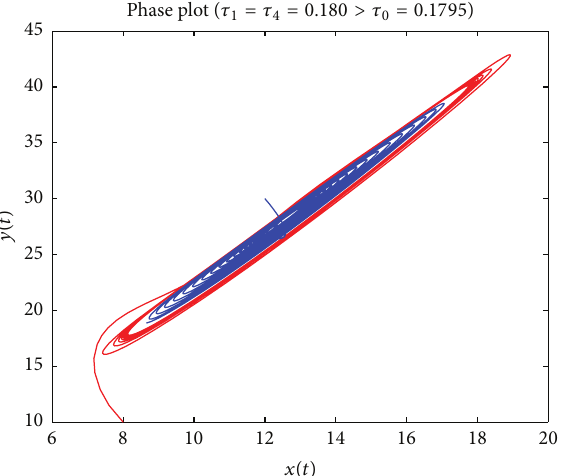
Figure9:ThisfigureshowsthattheHopfbifurcationissupercritical, and the bifurcating periodic solutions are asymptotically